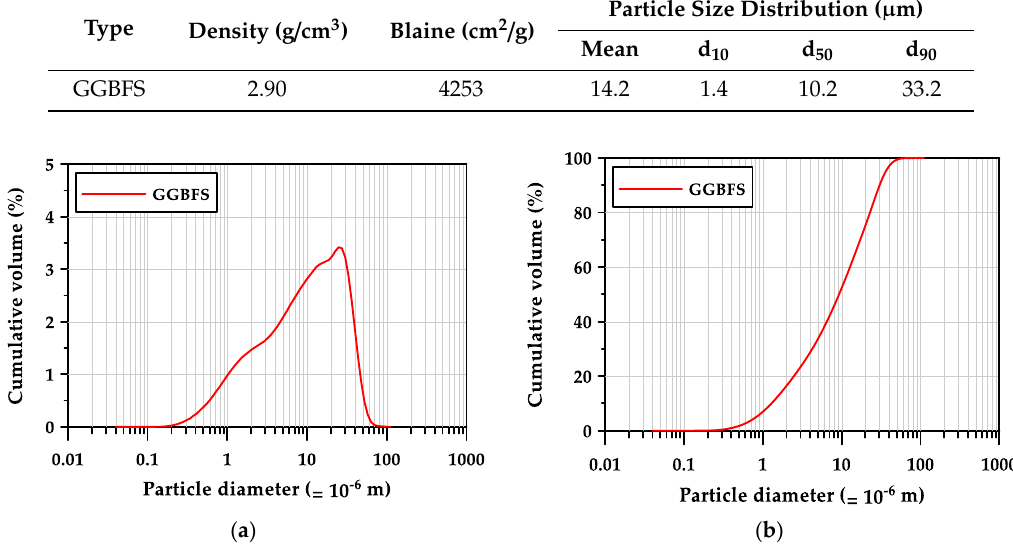
Table 2. Physical properties of GGBFS.